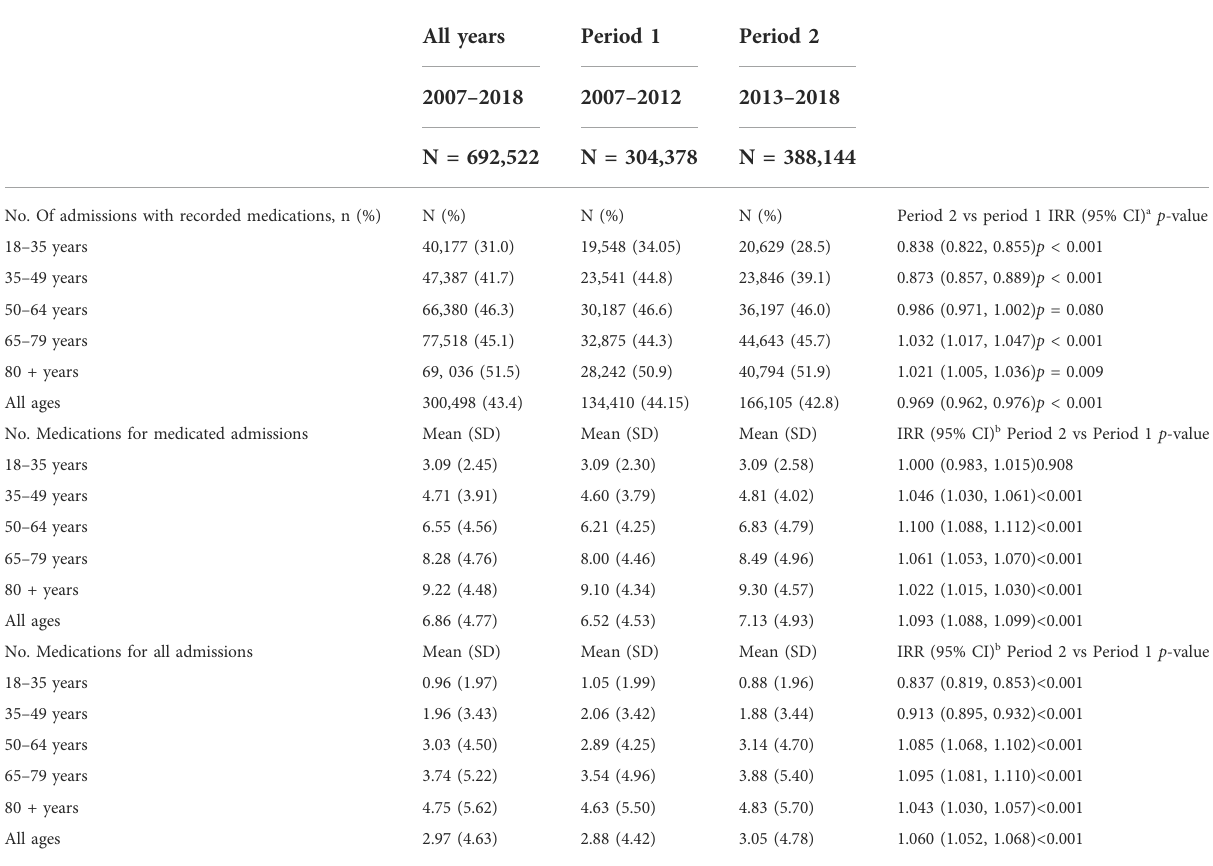
Figure 1, the medication use for some classes, e.g., proton pump